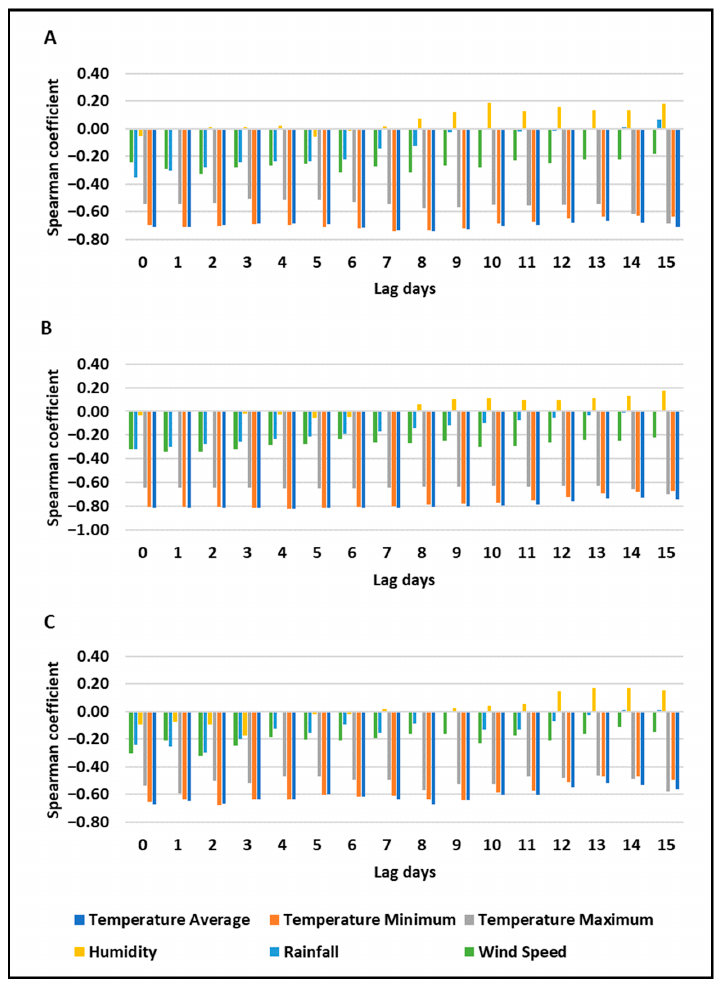
Figure 5. Variation of the Spearman coefficient for new cases ( A ), total cases ( B ), and mortality ( C ) with the meteorological variables in CABA. The lag day indicates up to 15 days prior to the confirmation date of cases and deaths. The values and their significance levels are also shown in Appendix A, Tables A2–A4. Humidity showed a higher positive correlation with total cases at 15 days lag (r = 0.18, p < 0.05), and rainfall showed significant correlations at day 0 (r = − 0.32, p < 0.01). Also, wind speed had a higher negative correlation at 2 days lag (r = − 0.27, p < 0.01) in total cases. Mortality (Figure 5C) presented higher negative correlation at 7 days lag (r = − 0.65, p < 0.01) for average temperature, at 2 days lag (r = − 0.68, p < 0.01) for minimum temperature and 1 day lag for maximum temperature (r = − 0.59, p < 0.01). Humidity and mortality cases did not show a significant correlation, but rainfall showed a high negative correlation at 2 days lag (r = − 0.33, p < 0.01). Also, wind speed displayed a high negative correlation at 2 days lag (r = − 0.32, p < 0.01). Few studies have investigated the relationship of SARS- CoV-2 virus infections with meteorological variables using days lag to consider their incubation time.